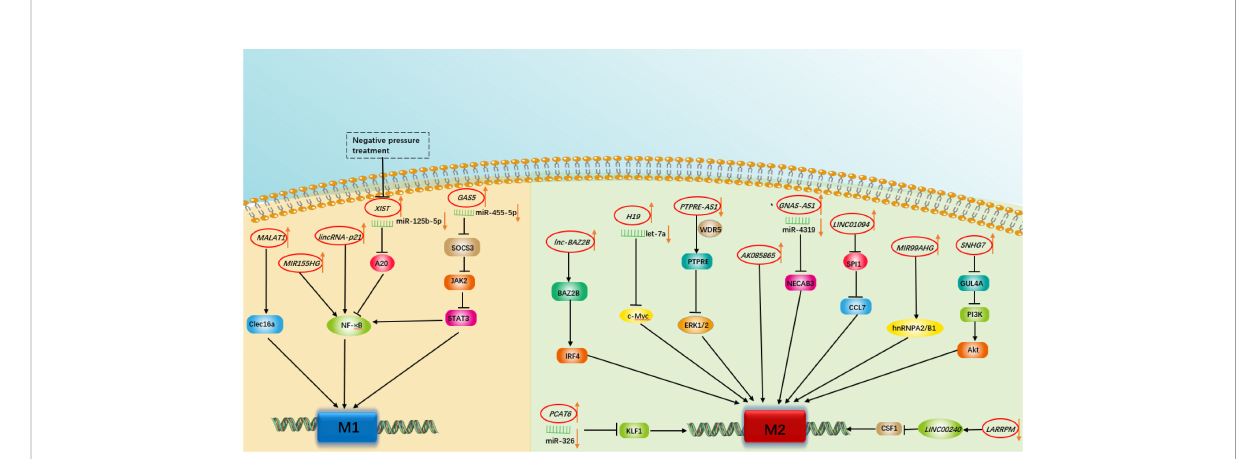
FIGURE 1 A schematic summary of the role of various long non-coding RNAs in modulating macrophage polarization involved in respiratory diseases.